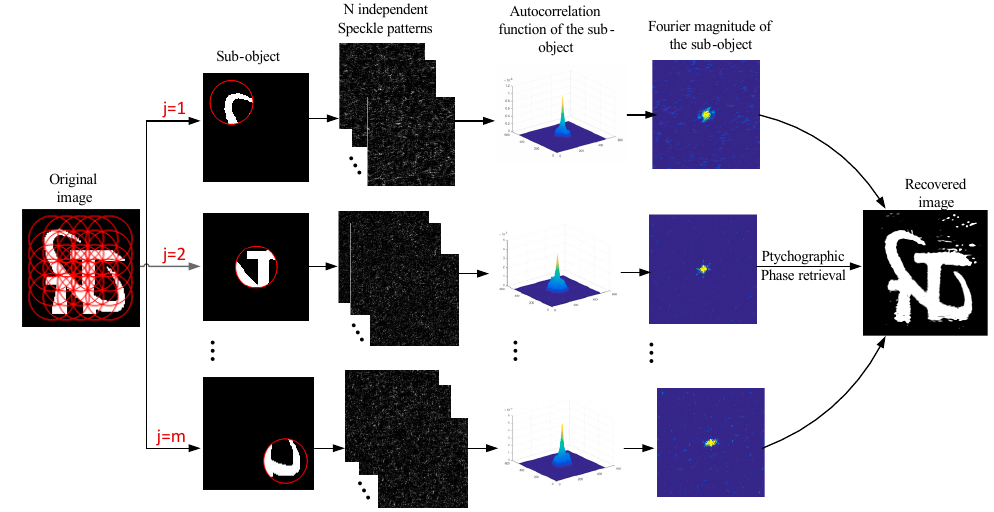
Figure 4. Block diagram of the imaging correlography with ptychography.